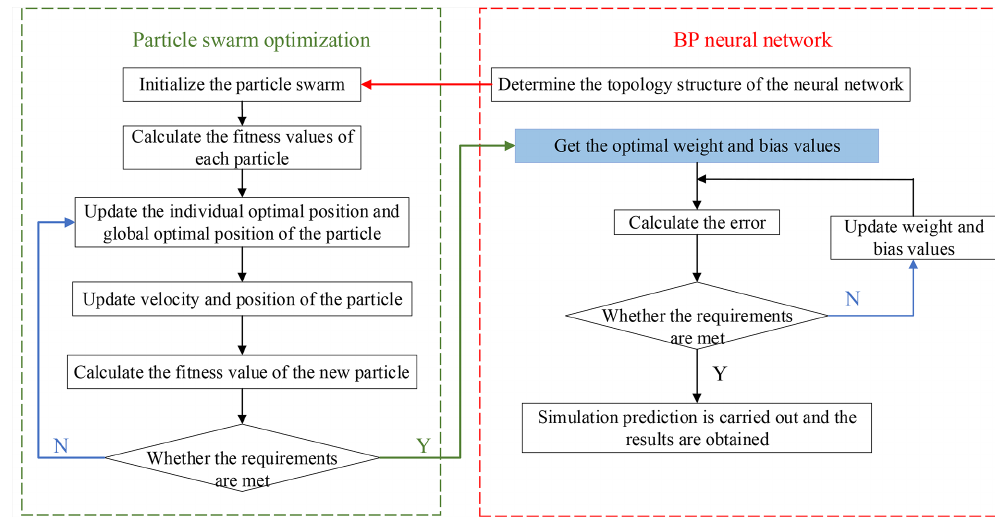
Figure 7. The flowchart of optimized BPNN based on improved particle swarm